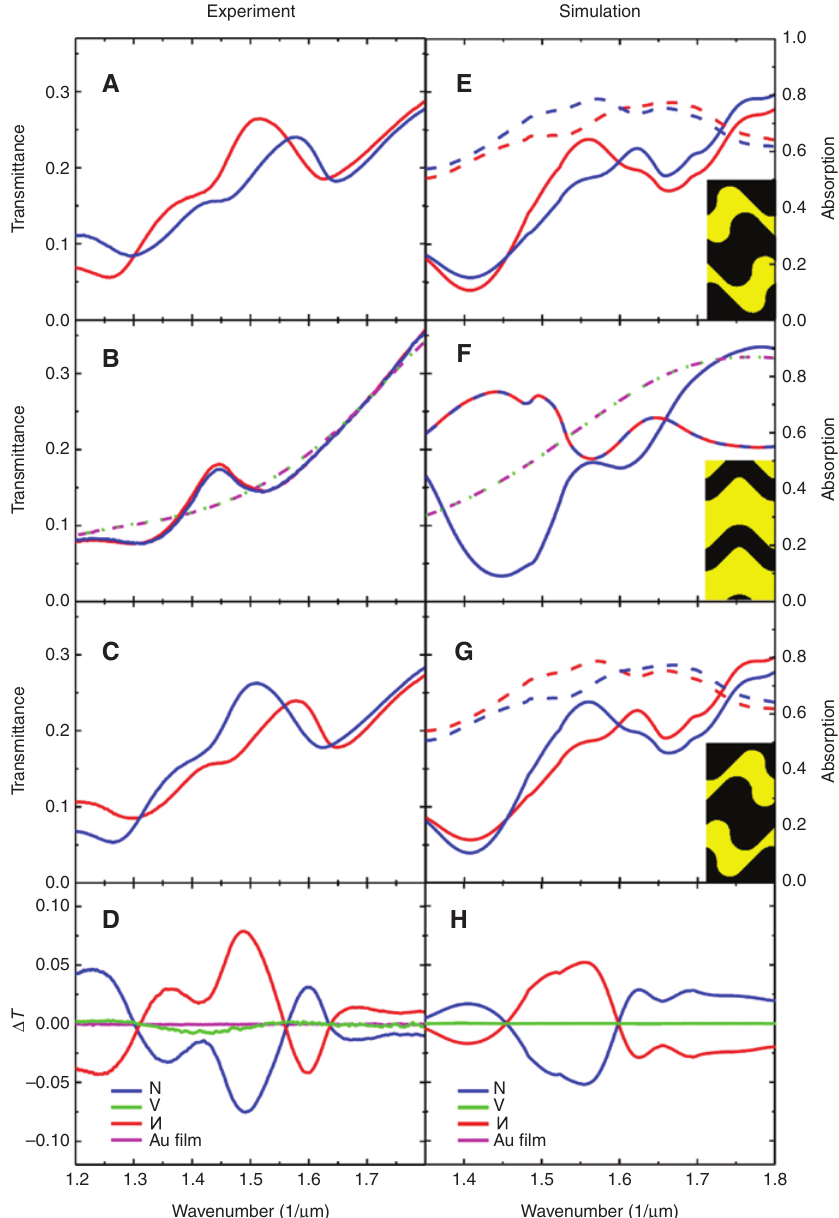
Figure 2: Transmittance and circular dichroism of complementary Au sawtooth metasurface. Transmittance of LCP (solid red curves) and RCP (solid blue curves) incidence light for (A) N -, (B) V - and (C) И -type complementary Au sawtooth metasurfaces. The magenta (LCP) and green (RCP) dashed curves in (B) are transmittance for Au film with no structure. (D) The transmission difference (CD) of T − T . (E)–(H) Corresponding results from CST simulations. The red/blue dashed curves in (E)–(G) are the absorptions for RCP LCP LCP/RCP incident light. Parameters for the simulations: thickness: Au 30 nm, PMMA 180 nm, ITO 65 nm, substrate glass 1 mm; sawtooth width (bottom layer): N - and И -type sawtooth metasurfaces – vertical bar 135 nm, slanted bar 110 nm, and V -type sawtooth metasurface slanted bars 120 nm. The insets show the unit cells used in the simulations. The gold color represents the top Au layer and the black is the bottom Au